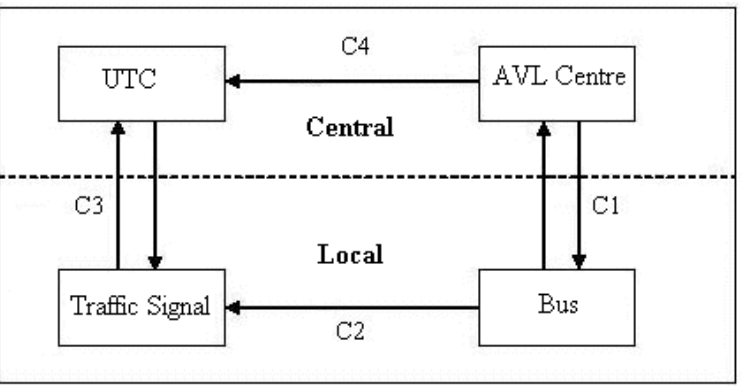
Figure 1. A simple illustration of bus priority